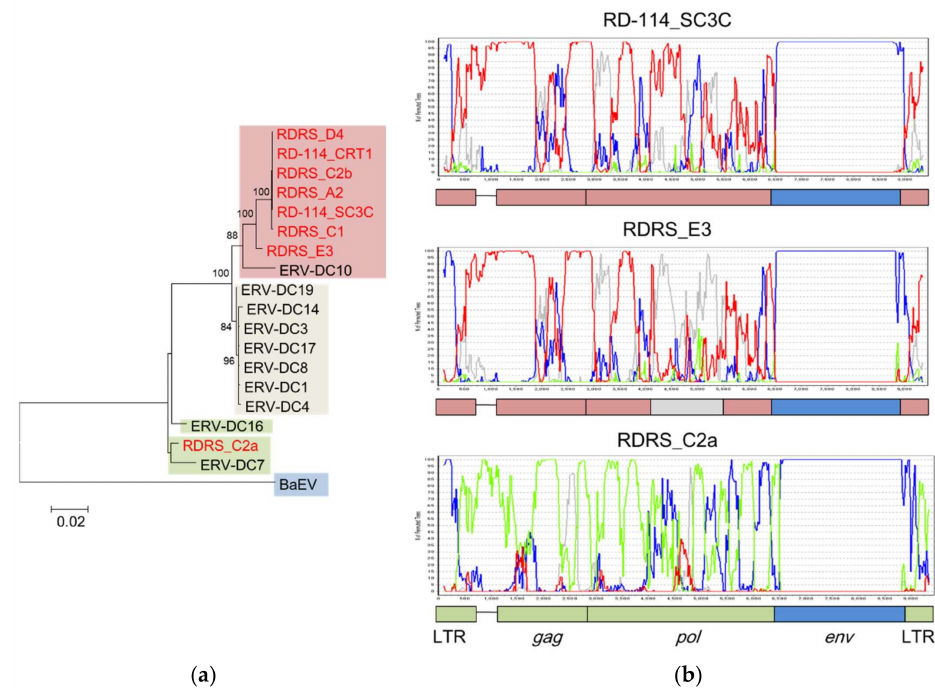
Figure 4. Repeated transduction of ERV-DC into RD-114 in independent events. ( a ) Phylogenetic tree based on the nucleotide sequences of the pol genes of ERV-DC, RD-114, and RD114-virus-related sequences (RDRSs). RD-114 and RDRS are shown in red letters. The sequences are shown in the following colors, according to clade: ERV-DC genotype I (GI) clade: gray; ERV-DC genotype II (GII) clade: green; ERV-DC genotype III (GIII) clade: red; and baboon endogenous retrovirus (BaEV) clade: blue. ( b ) Recombination analysis of RD-114_SC3C, RDRS_E3, and RDRS_C2a with bootscanning, using the nucleotide sequences of ERV-DC GI, GII, GIII, and BaEV. The vertical axis represents the percentage of permuted trees and the horizontal axis represents the alignment position. Each line is colored as follows: ERV-DC GI, gray; ERV-DC GII, green; ERV-DC GIII, red; and BaEV, blue. The bootscanning analysis was conducted with Simplot [62]. Sequences for the analysis were extracted with a window size of 200 bp and a step size of 20 bp, and each phylogenetic analysis was repeated 100 times with the neighbor-joining method based on the Kimura 2-parameter model [63]. The accession numbers of the nucleotide sequences are: ERV-DC: AB674439–AB674452, AB807599, and